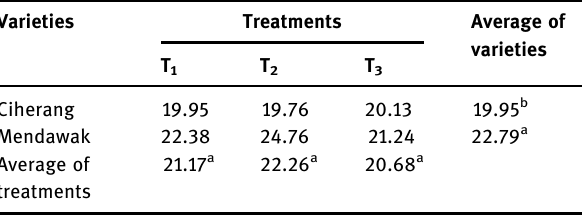
Table 5: Grain yield comparison of organic manure and